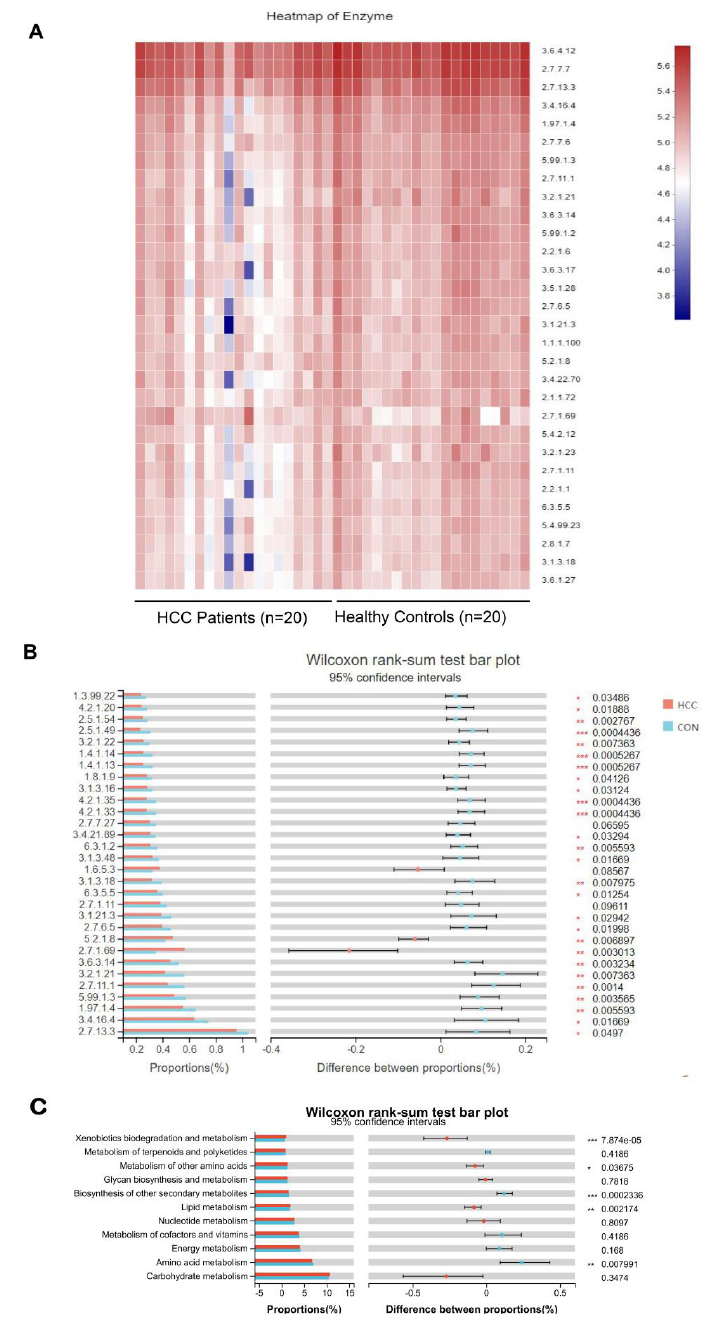
Figure 5. ( A ) HCC group and CON group are presented as X axis, and KEGG enzyme number is presented as Y axis. The color gradient of the color block is used to display the changes in the different functions between groups. The legend is the value represented by the color gradient. ( B , C ) Enzyme abundance and differences between HCC group and CON group. * p < 0.05, ** p < 0.01, *** p < 0.001. Wilcoxon rank-sum test was